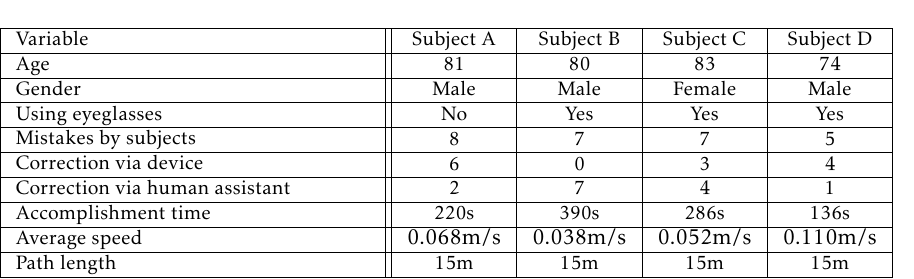
Table 3. The relevant descriptive statistics and factors are measured for four elderly subjects suffering from mild dementia in walking experiment.